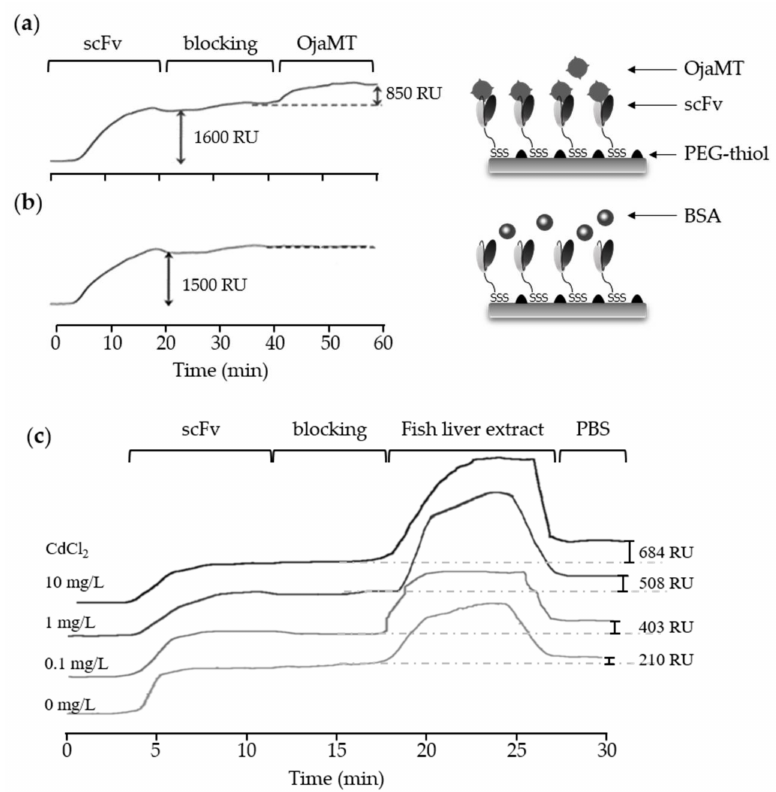
Figure 4. OjaMT detection using SPR chip presenting recombinant anti-OjaMT scFv. ( a ) Recombinant scFv (50 µ g/mL) was immobilized on a gold surface, and antigen-OjaMT (30 µ g/mL) was then flowed at a rate 10 µ L/min for 10 min. ( b ) The immobilized recombinant scFv fragments (50 µ g/mL) showed non-specific binding with BSA, control protein (30 µ g/mL). ( c ) The presence of OjaMT in heavy metal contaminated fish liver was monitored using a scFv-immobilized sensor chip. All the contaminated samples showed increased ∆ RU, suggesting the increase in OjaMT